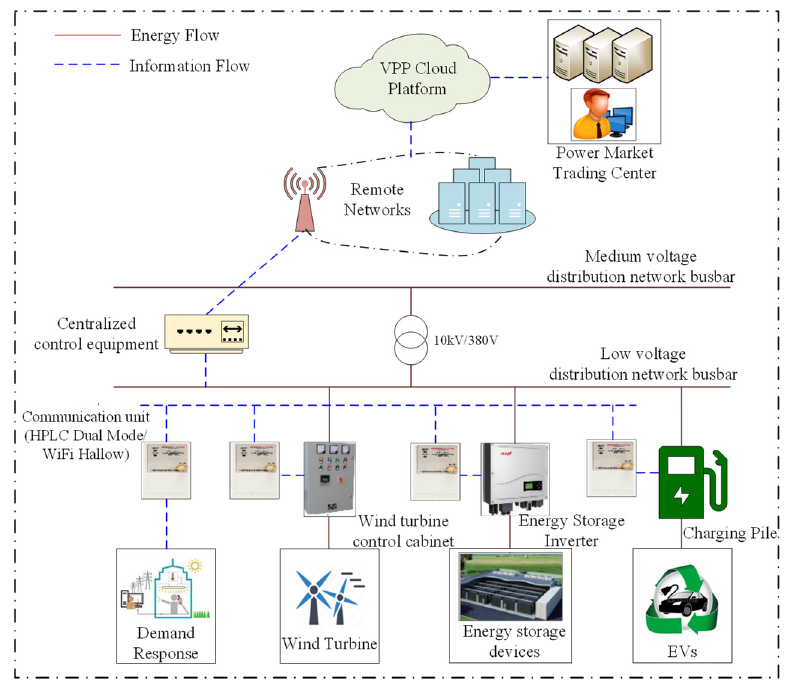
Figure 1. The communication structure of the VPP interacting with the power grid .